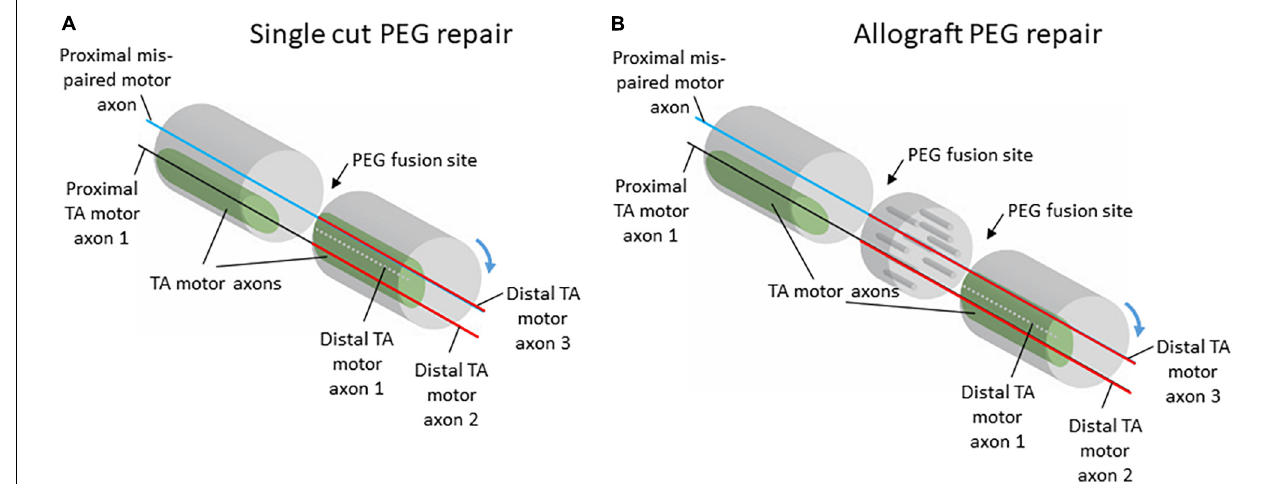
FIGURE 4 | Schematic diagrams of potential proximal and distal axon fusing after single-cut (A) or allograft (B) repair with PEG-fusion. Although there is no expectation for specific re-pairing of severed axons with PEG-fusion, the relatively large and consistently located territory occupied by TA motor axons in the sciatic nerve allows for appropriate realignment of proximal and distal axon segments. Despite misalignment of axon populations through rotations of the nerve stumps during repair, the topography of TA motor axons would allow for some correct populations of proximal and distal axons to be